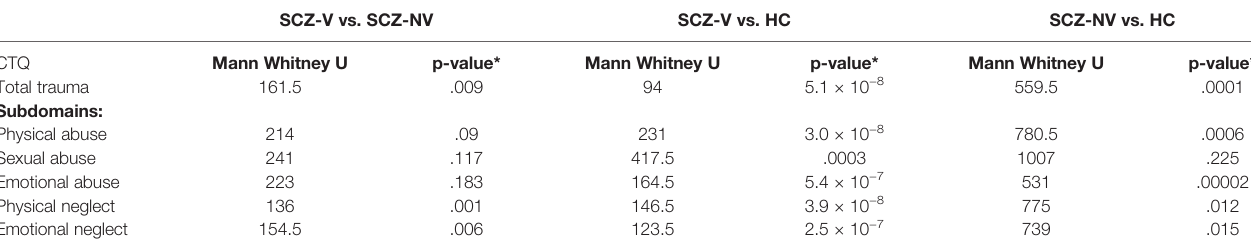
TABLE 3 | Pairwise comparisons of childhood trauma scores between patients with (SCZ-V) and without (SCZ-NV) a history of violence, and healthy controls (HC).